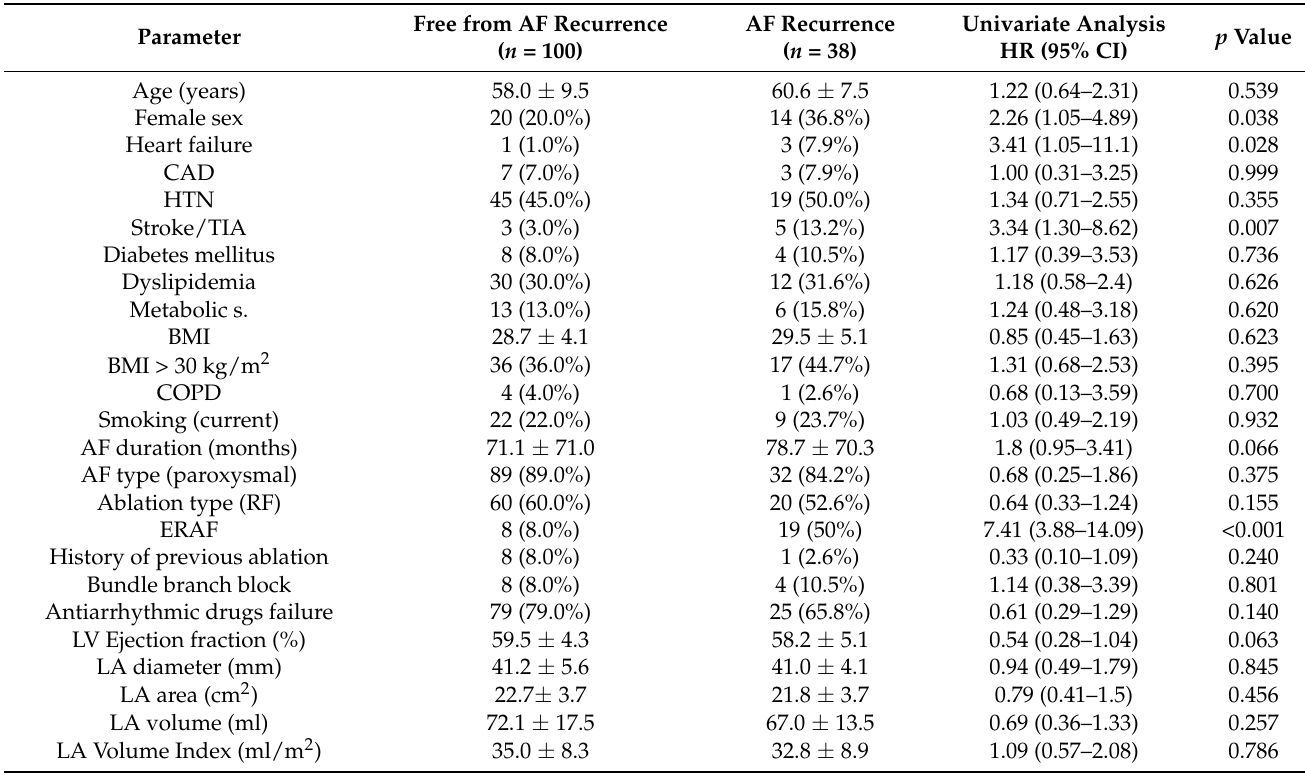
Table 3. Clinical parameters comparison.